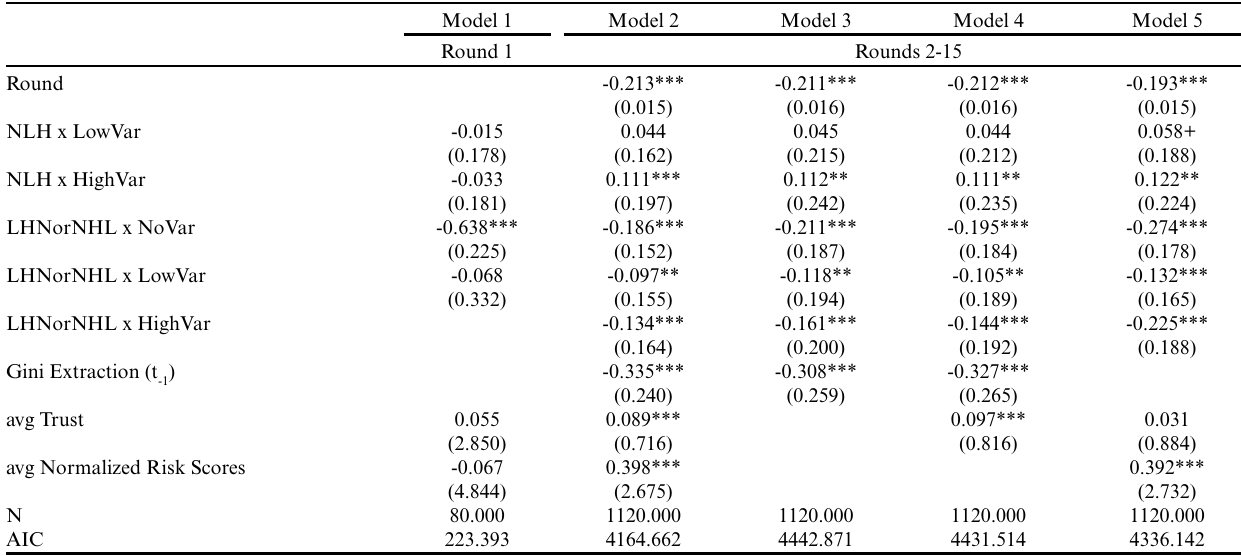
Table 5 . Results for the group-level model with standardized